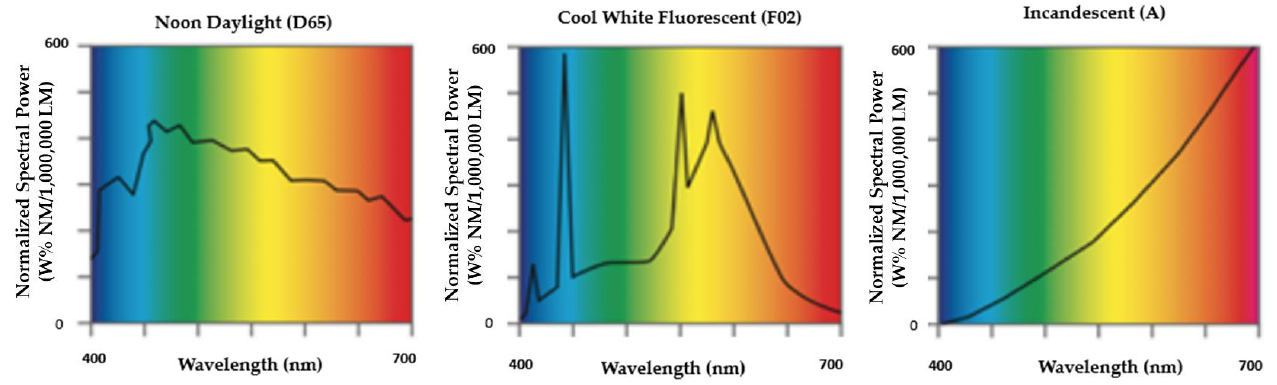
Figure 6. Images of reflectance spectra [43].